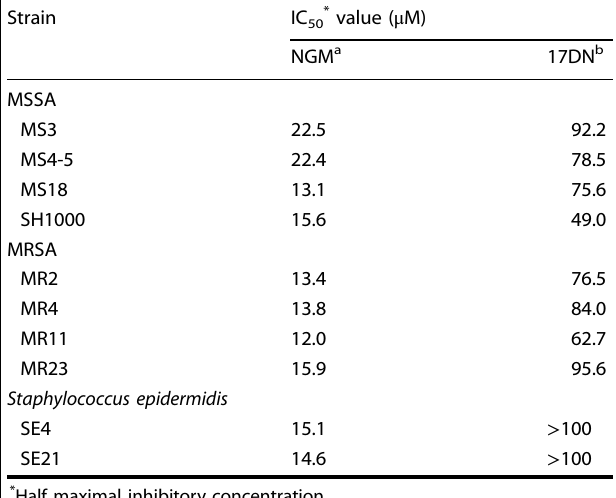
Table 1. Bio fi lm inhibitory activities of NGM and 17DN against various staphylococcal strains